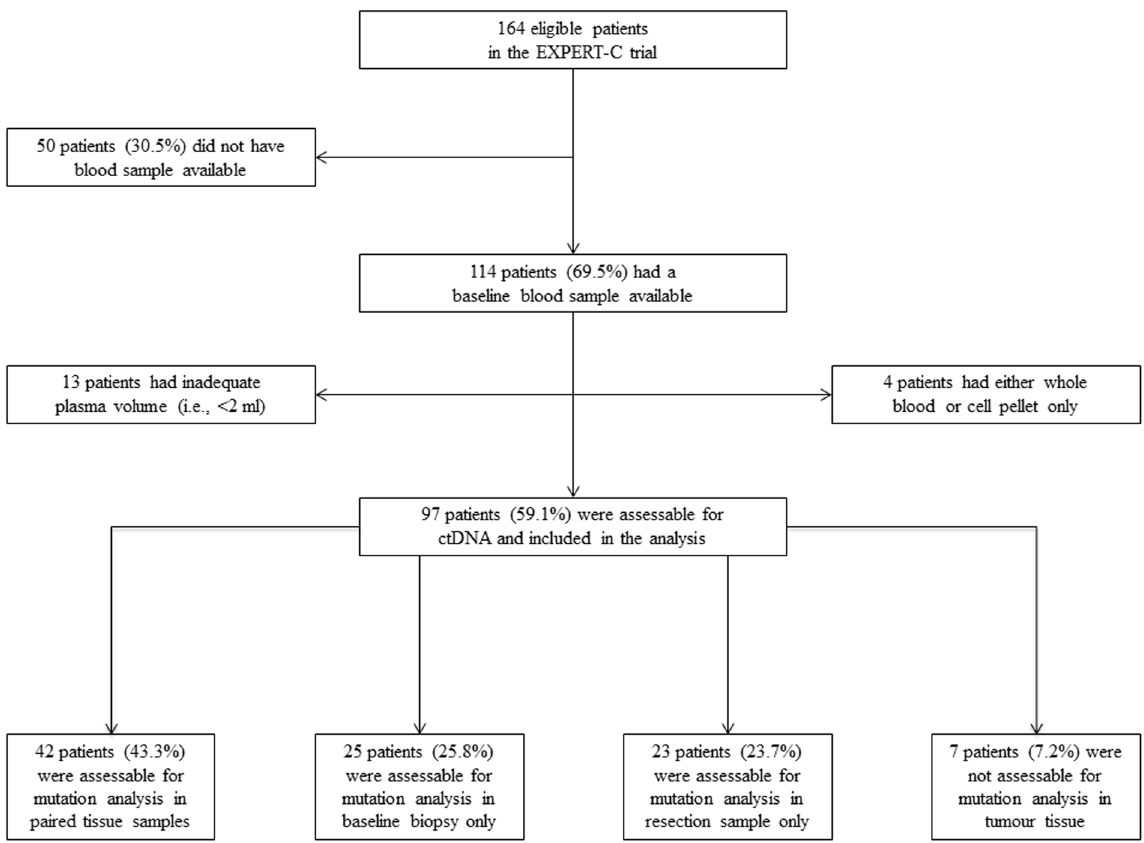
Figure 1. Study flow diagram and tissue availability in the ctDNA assessable population.